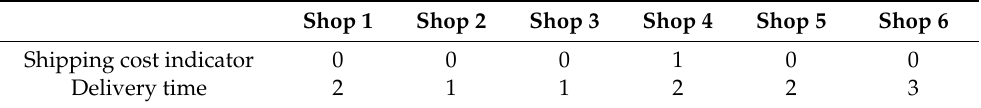
Table 7. The result of numerical solution (shops).